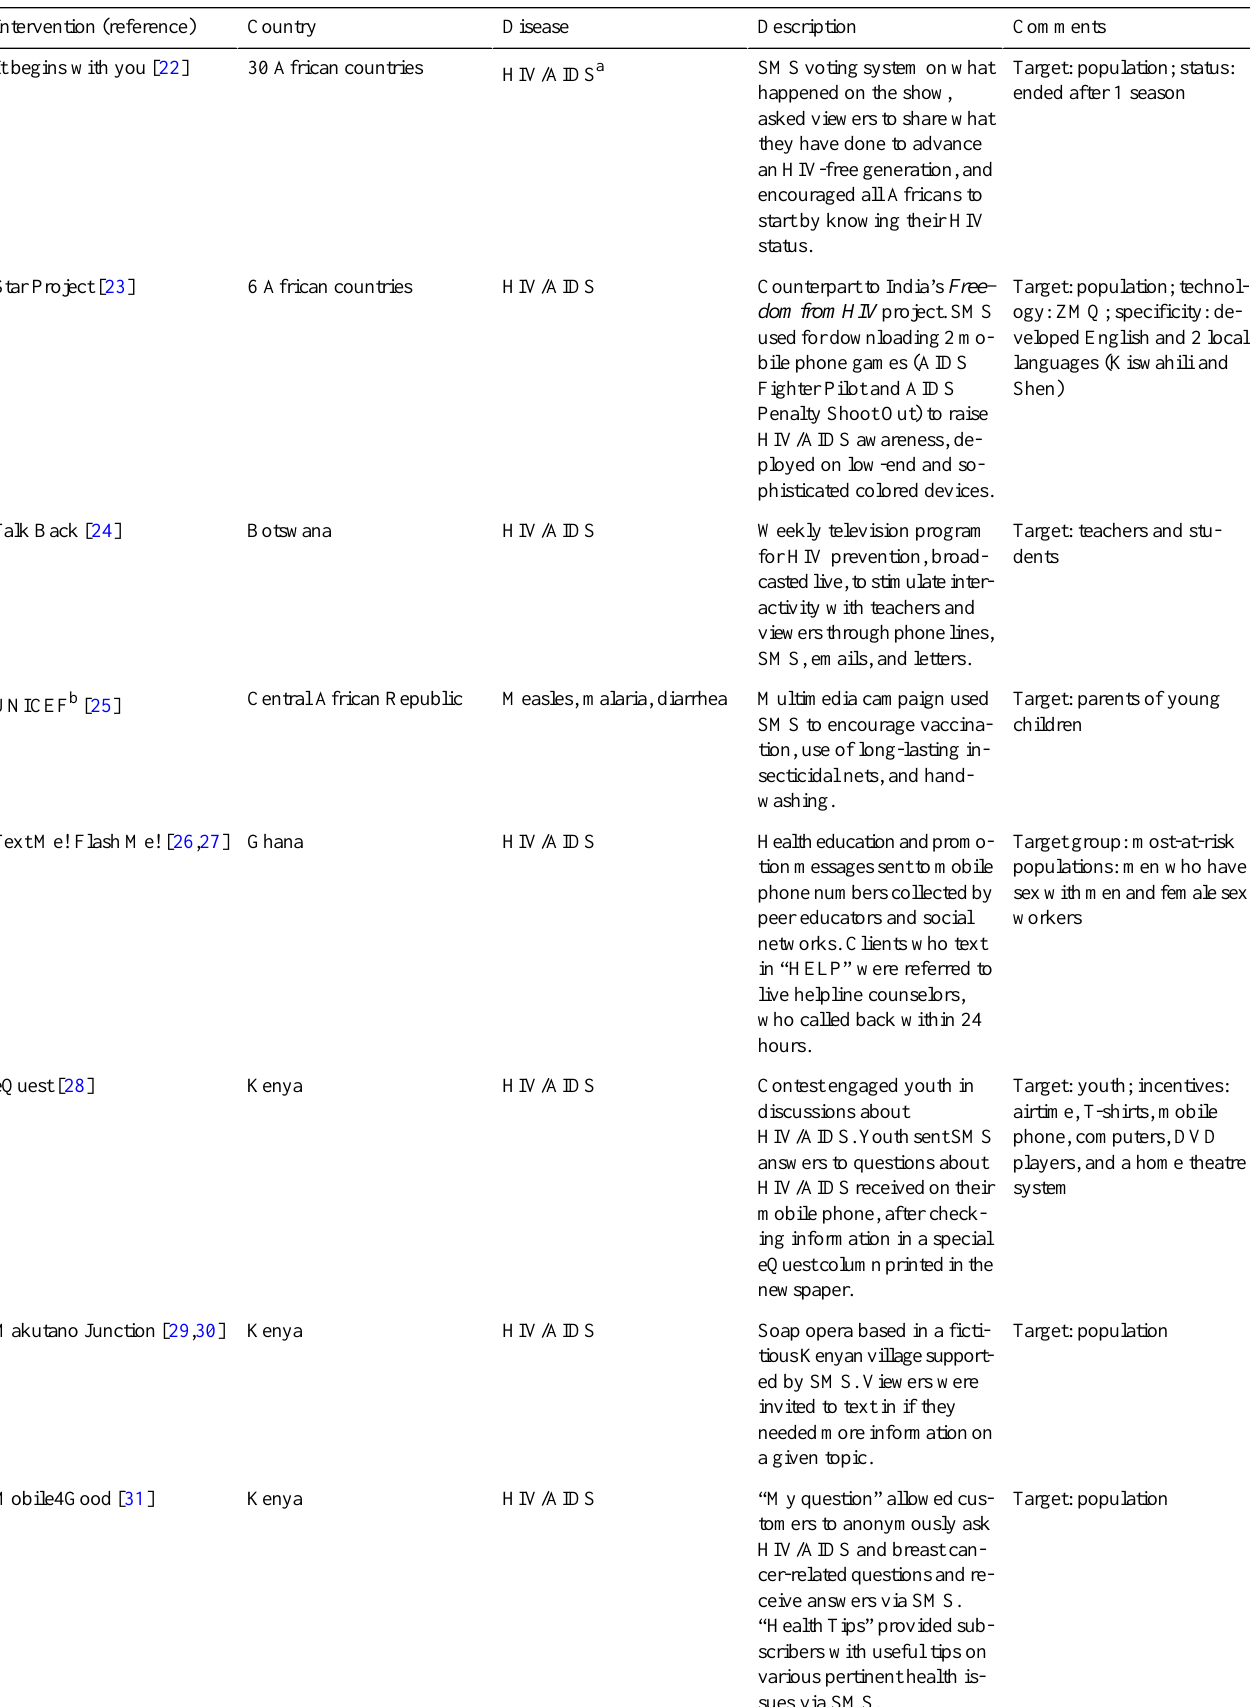
Table 1. Short message service (SMS) interventions for disease prevention CommentsDescriptionDiseaseCountryIntervention